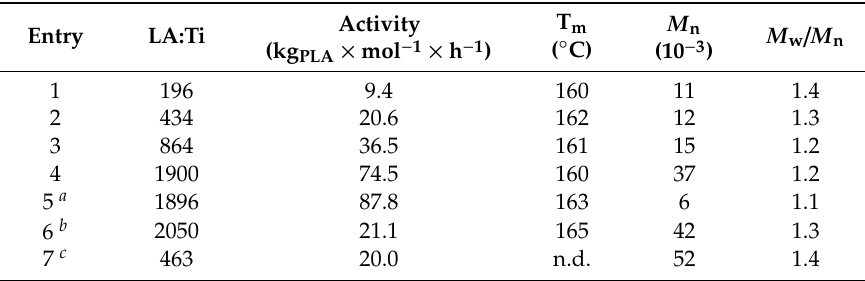
Table 18. Polymerization of L-lactide catalyzed by 64